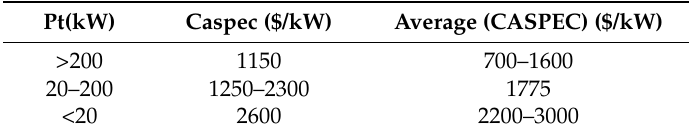
Table 3. Nominal rated power specific costs per kW of wind turbine.